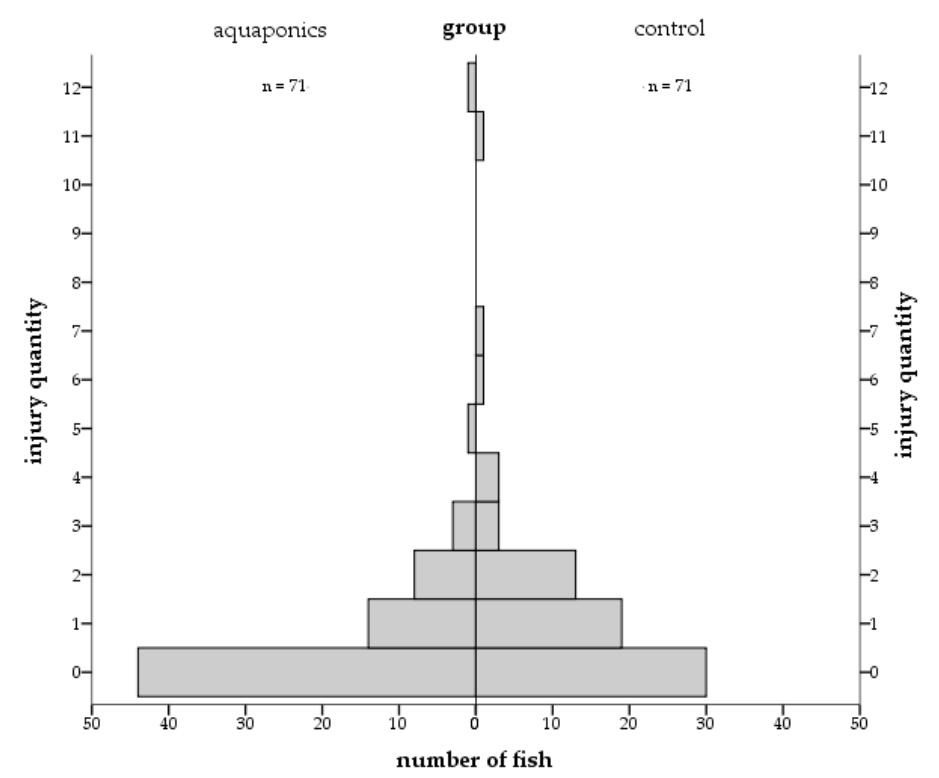
Figure 14. Quantity of external injuries on African catfish ( C. gariepinus ) in different cultivation groups. Illustrated is the sampling in small groups over the entire experiment.